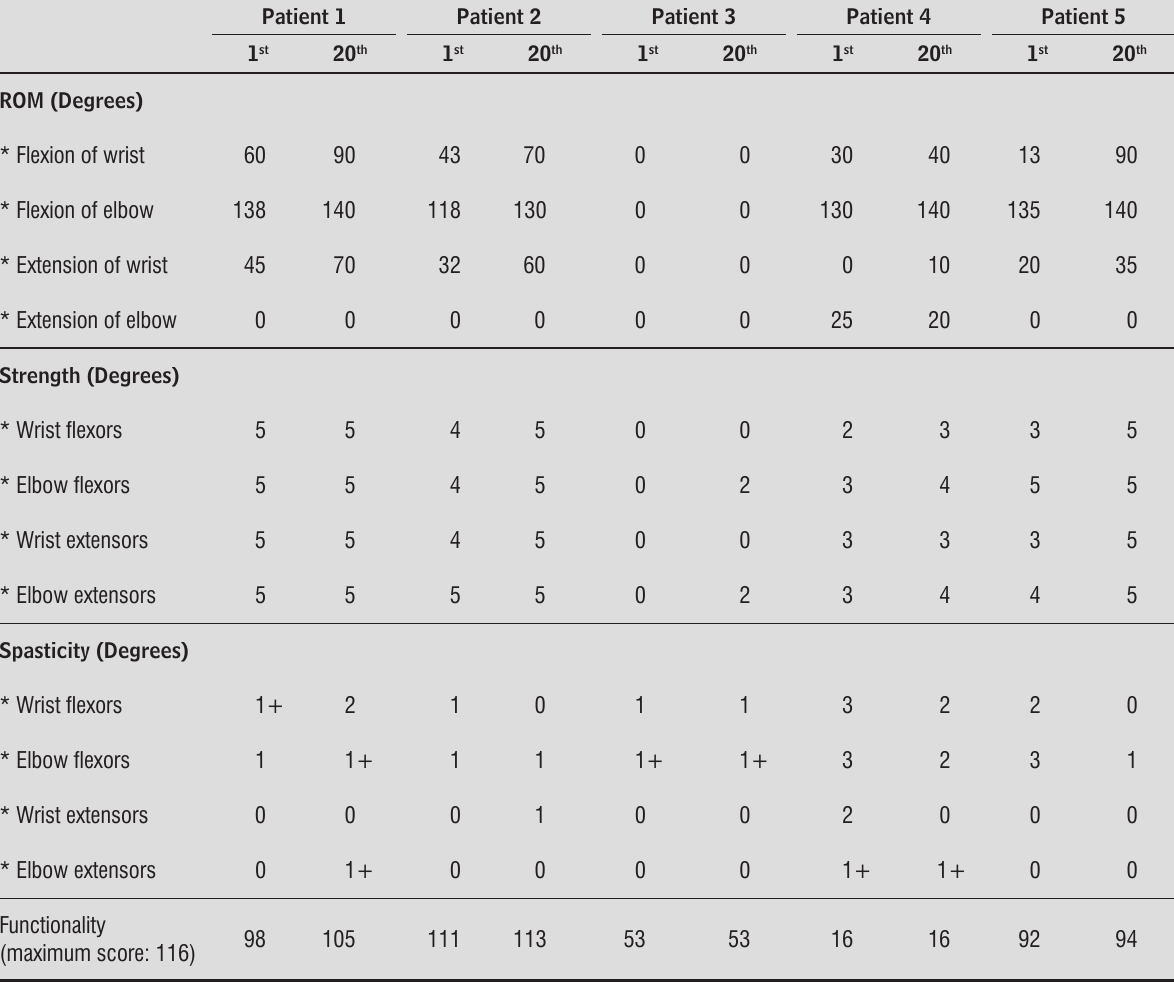
Table 1 - Range of motion, strength, spasticity and functionality of patients at the 1 st and 20 th sessions